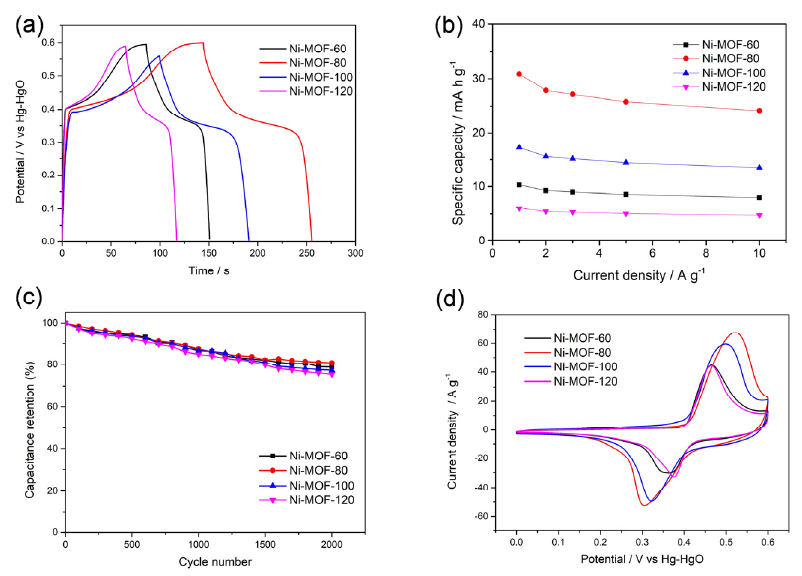
Figure 4. ( a ) GCD drawings of different Ni-MOFs at 1 A g − 1 ; ( b ) Specific capacity of four samples within the range of 1.0 − 10.0 A g − 1 ; ( c ) Capacity retention performance of four samples; ( d ) CV curves of different Ni-MOFs at 100 mV s − 1 .